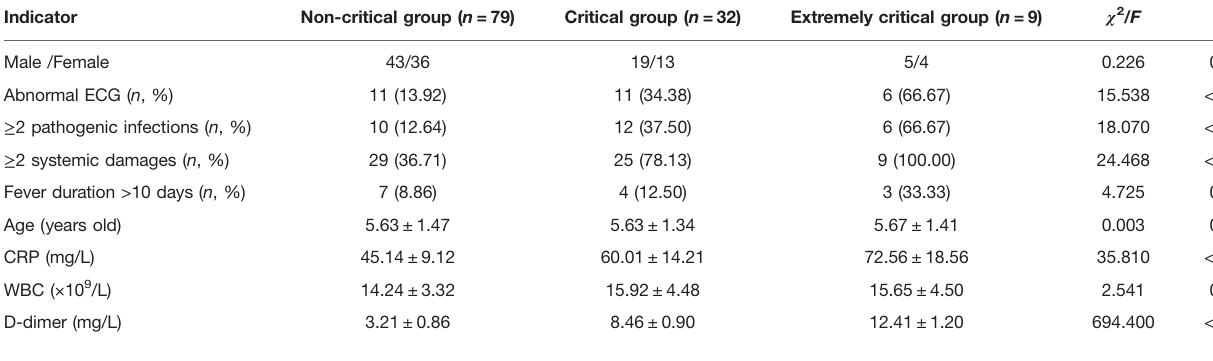
TABLE 1 | Analysis of clinical characteristics of 120 children with